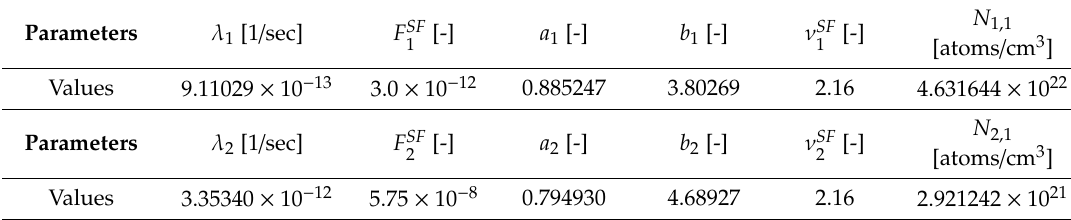
Table 3. Nominal values of the source parameters for the PERP benchmark